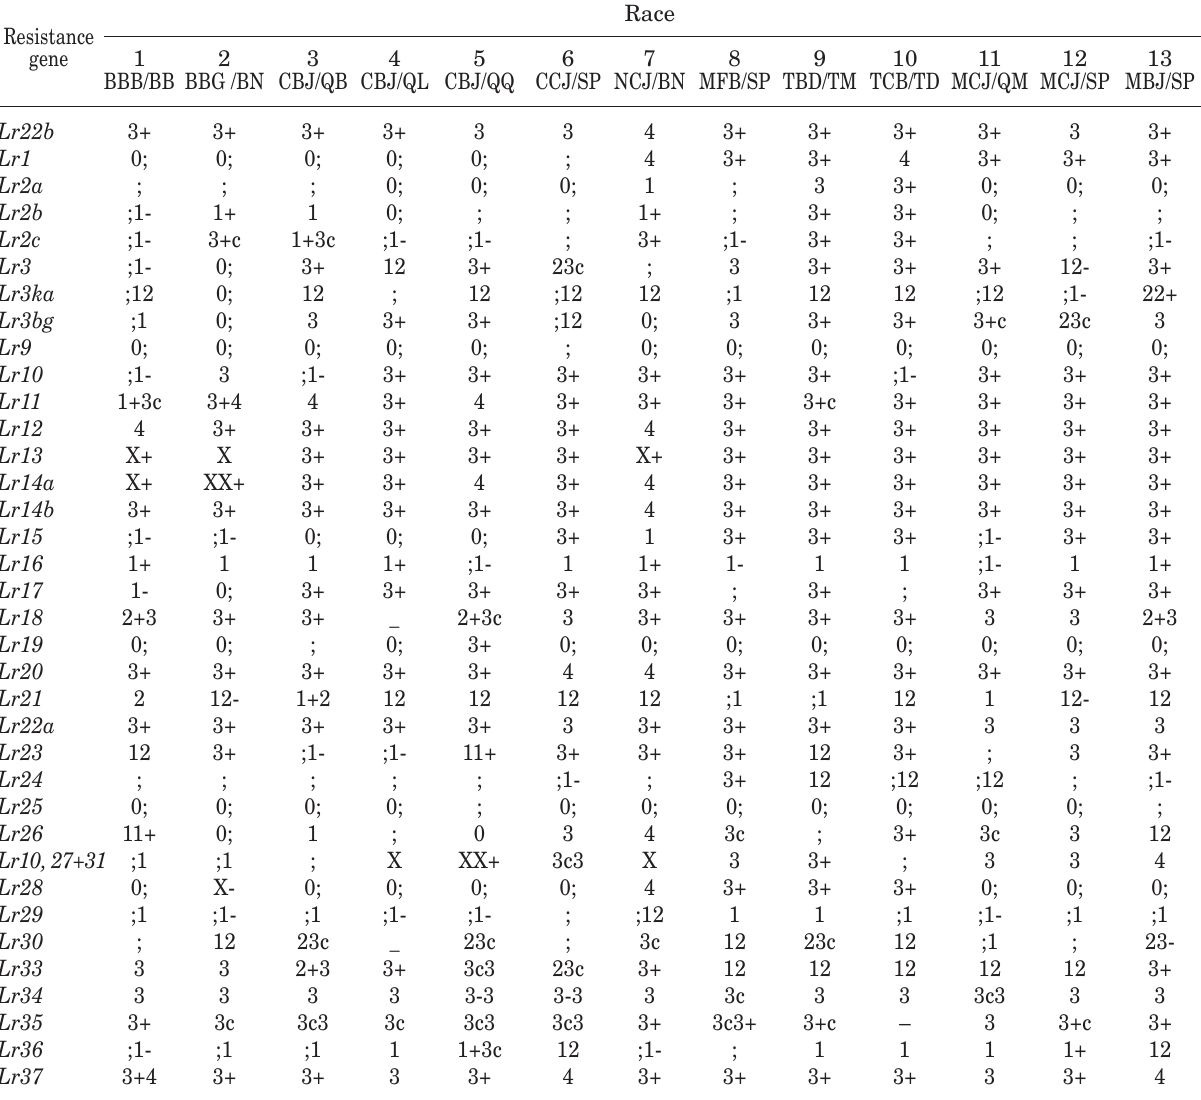
Table 2. Seedling reactions (infection types) displayed by known Lr gene testers when inoculated with 13 races of Puccinia triticina